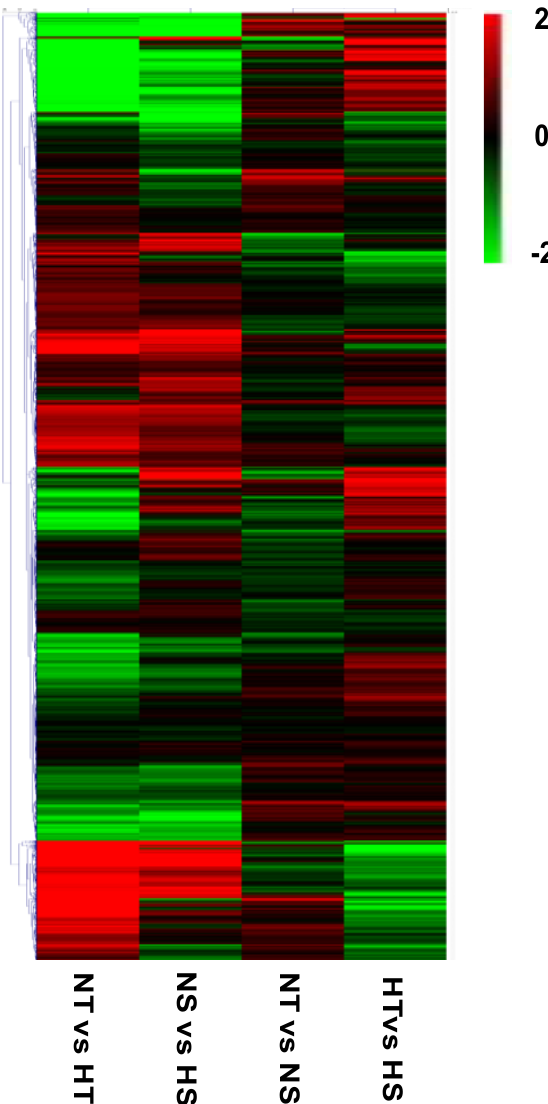
Figure 8. Hierarchical clustering of DEGs identified under NT, HT, NS, and HS based on Gene Ontol- ogy (GO) terms, showing GO category distribution. NT, normal growth condition under 25/18 ◦ C and water; NS, normal growth condition under 25/18 ◦ C with 1 mM Spd treatment on plants; HT, high temperature growth condition on 38/28 ◦ C and water treatment; HS, high temperature growth condition on 38/28 ◦ C with 1 mM Spd treatment on leaves.